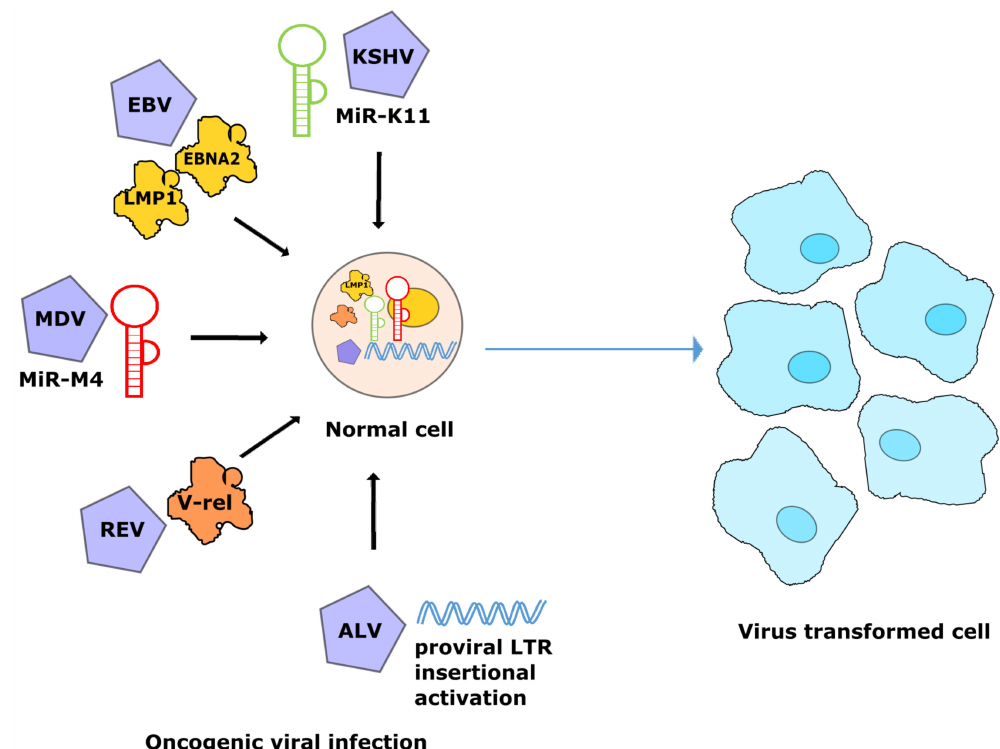
Figure 3. Conserved mechanisms of transformation by oncogenic viruses using miR-155 pathway. Expression of viral homologs of miR-155 (MDV-miRM4, and KSHV-miR-K11), activation of miR-155 expression through virus-encoded/transduced oncoproteins (EBV-encoded EBNA2, LMP1, and REV-transduced v- rel ) and direct insertional activation of bic gene by avian leukosis virus (ALV)